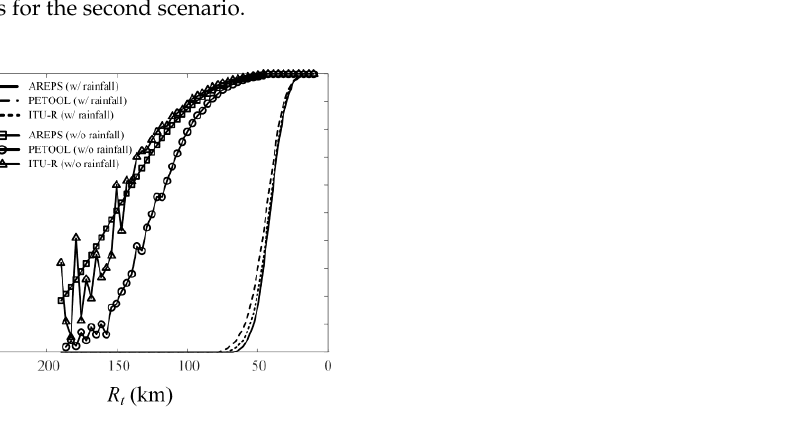
Figure 9. Contour plot of TDP according to different weather conditions in the sub- and normal refractions for the second scenario.